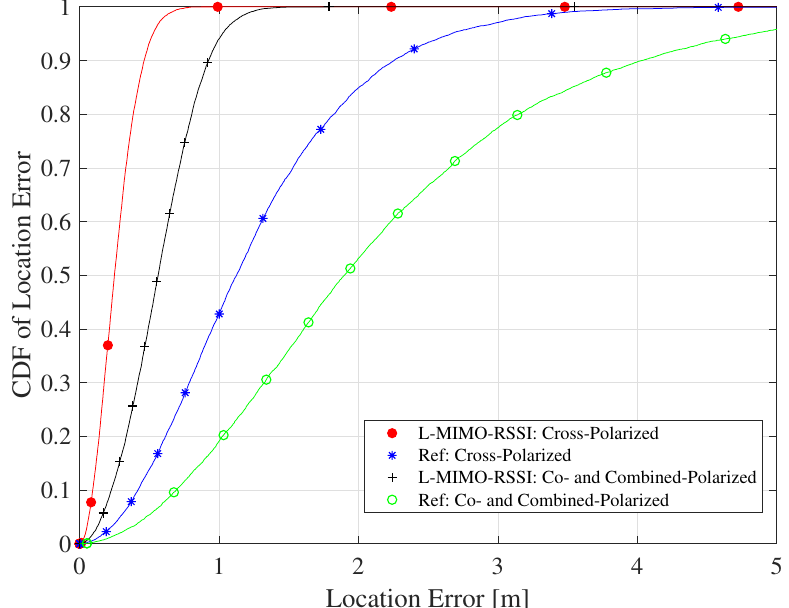
Figure 12. The CDF of localization RMSE for different position estimation algorithms for the NLOS environment and the co-, cross- and combined-polarized antenna